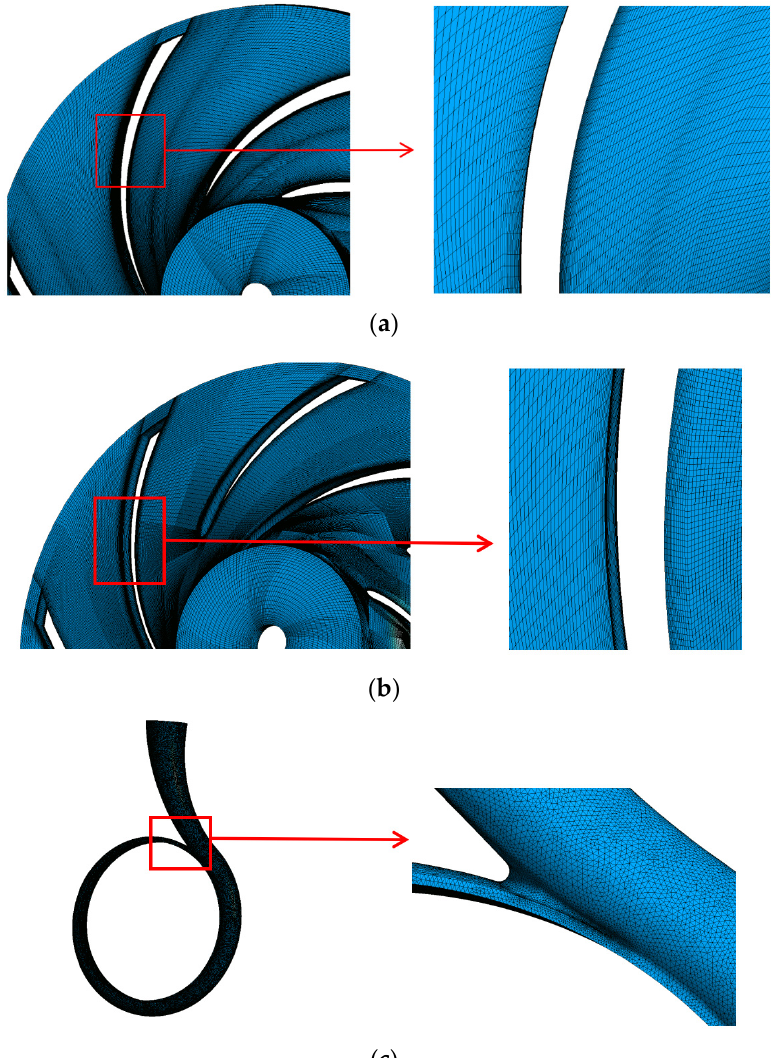
Figure 2. Meshes in the flow channels of the CFD pump model: ( a ) cylindrical blades impeller; ( b ) splitter blades; ( c ) volute.